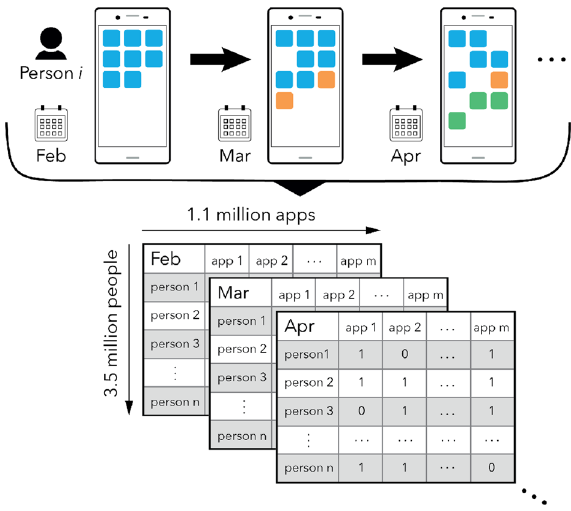
Figure 1. Smartphone app usage patterns change over time. This study is based on smartphone app- fingerprints of 3,556,083 individuals from 33 countries. For each month between February 2016 and January 2017, we retrieve the list of apps a person has used during the period. On average a person uses n month = 23 unique apps per month, however, individuals continuously revise which apps they use, and use n year =